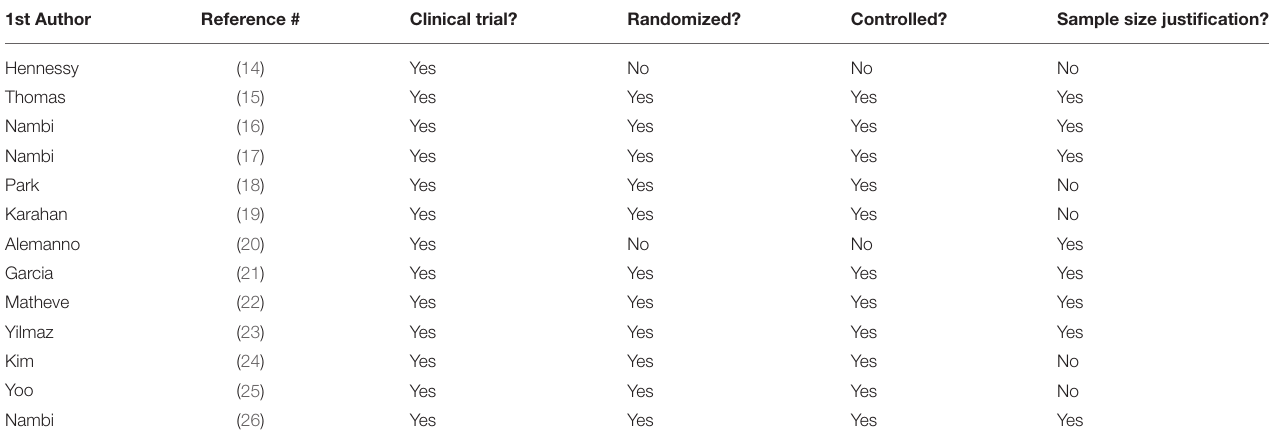
TABLE 1 | Summary analysis of all included articles to assess for study